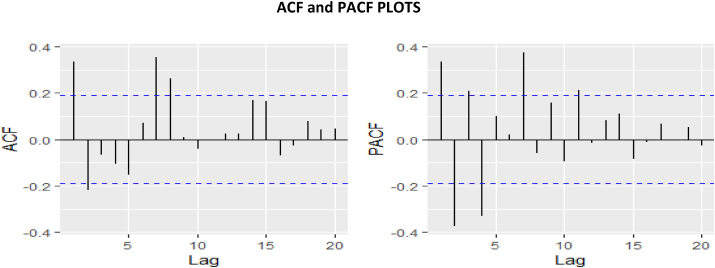
ACF and PACF for SA